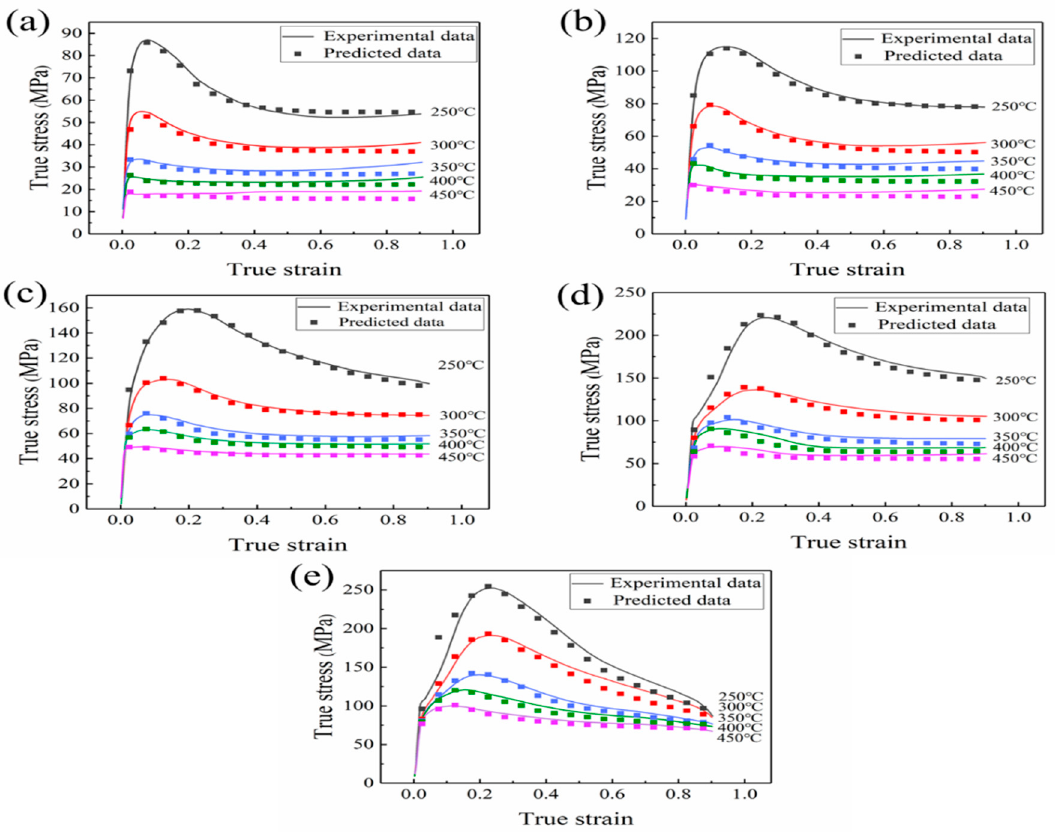
Figure 5. Comparisons between the predicted and measured flow stresses at different strain rates of ( a ) 0.001, ( b ) 0.01, ( c ) 0.1, ( d ) 1 and ( e ) 10 s − 1 .